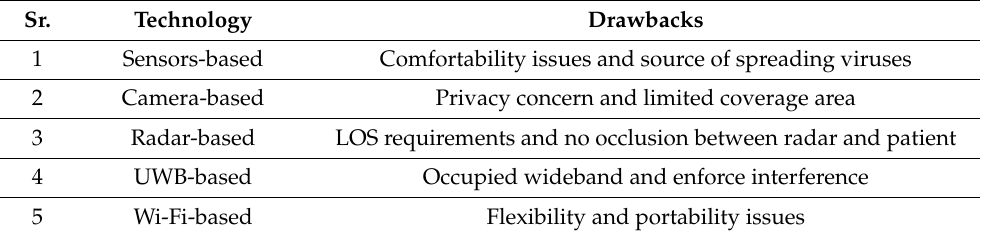
Table 1. Summary of existing connected health technologies drawbacks.